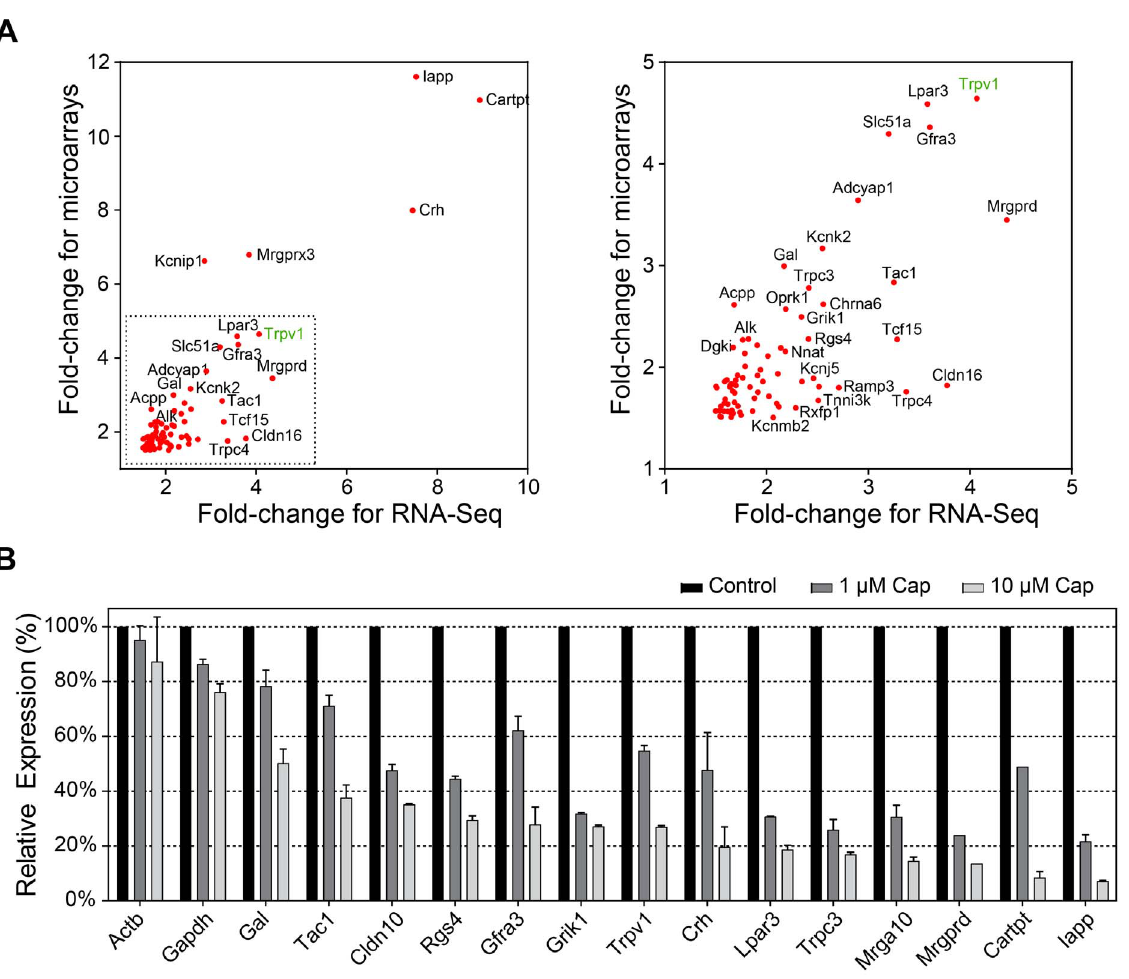
Fig. 3. Validation of transcriptome data. (A) Correlation of fold-changes obtained by microarray hybridizations and RNA-Seq (Spearmans r 5 0.66, p , 0.0001). (B) qPCR validation of 14 transcripts identified as differentially expressed by microarray hybridizations or RNA-Seq. The depletion of TRPV1( + ) neurons was performed with capsaicin (1 and 10 m M) for 30 min. The reduction of all target transcripts is